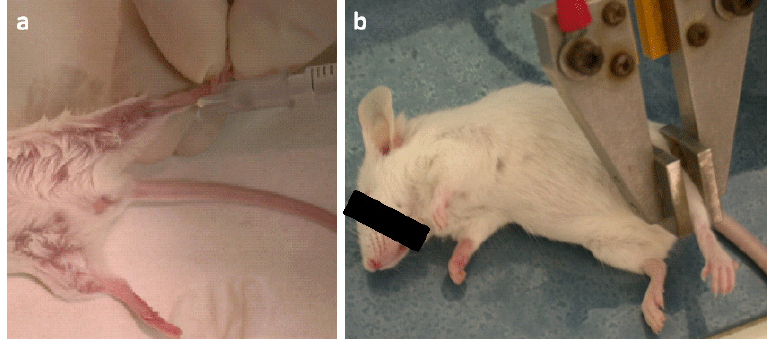
Figure 1. Electro gene transfer performed with the T820 electroporator (BTX, San Diego, CA, USA). (a) 25 µ g of plasmids diluted in 20 µ L of 0.9% NaCl with 6 mg/mL